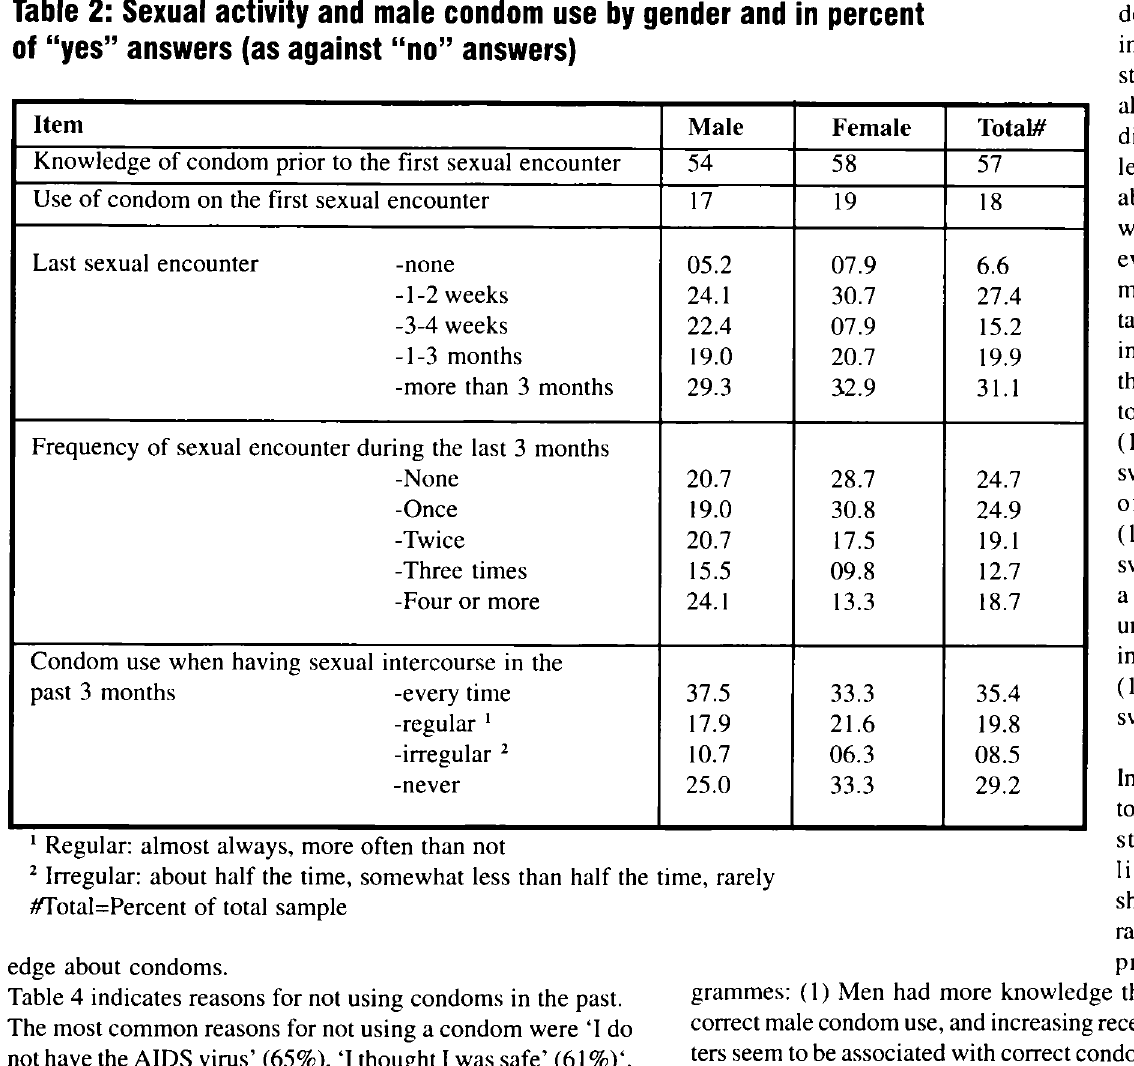
Table 2: Sexual activity and male condom use by gender and in percent of “ yes” answers (as against “ no” answers) Item